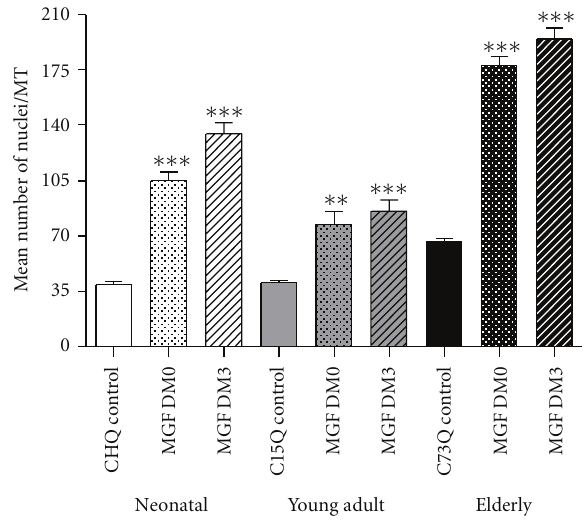
Figure 5: In elderly muscle MGF treatment activates “resting” cells to proliferate and fuse to donate nuclei. Cultures from neonatal, young adult, and old adult muscle were treated with the unique MGF peptide (MGF E) 24aa at a concentration of 100 ng/mL at day 0 or day 3 of di ff erentiation. Immunofluorescence was performed on cultures with an antibody directed against Desmin (a marker of progenitor cell status). In elderly muscle there are still some muscle satellite/stem cells in a quiescent state but these are not normally activated because older muscle does not normally produce much MGF. However when the unique E peptide of the MGF was added to cultures from elderly muscle these cells replicated. The prospects of “awakening” of these resting progenitor cells appear to o ff er a means of enhancing muscle maintenance and repair in the elderly o ff ers and in certain diseases such as muscular dystrophy and ALS (Kandalla et al.